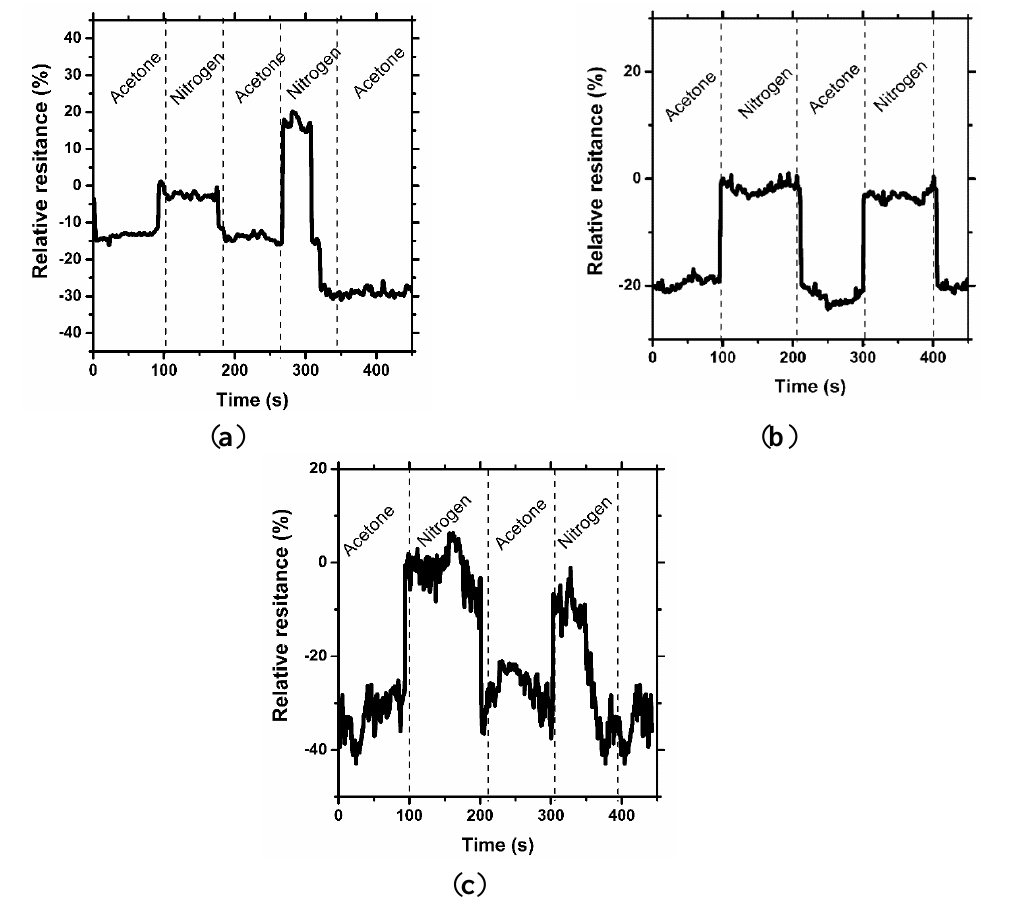
Figure 4. Characteristic sensing properties at 200 ppm acetone vapor for ( a )